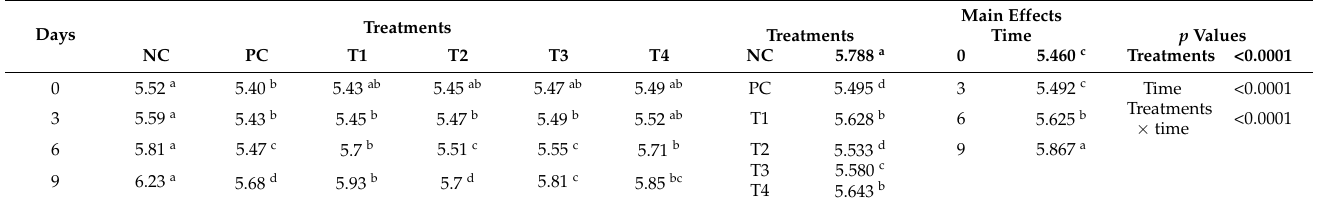
Table 2. Changes in pH values of pork mince depending on treatment and storage